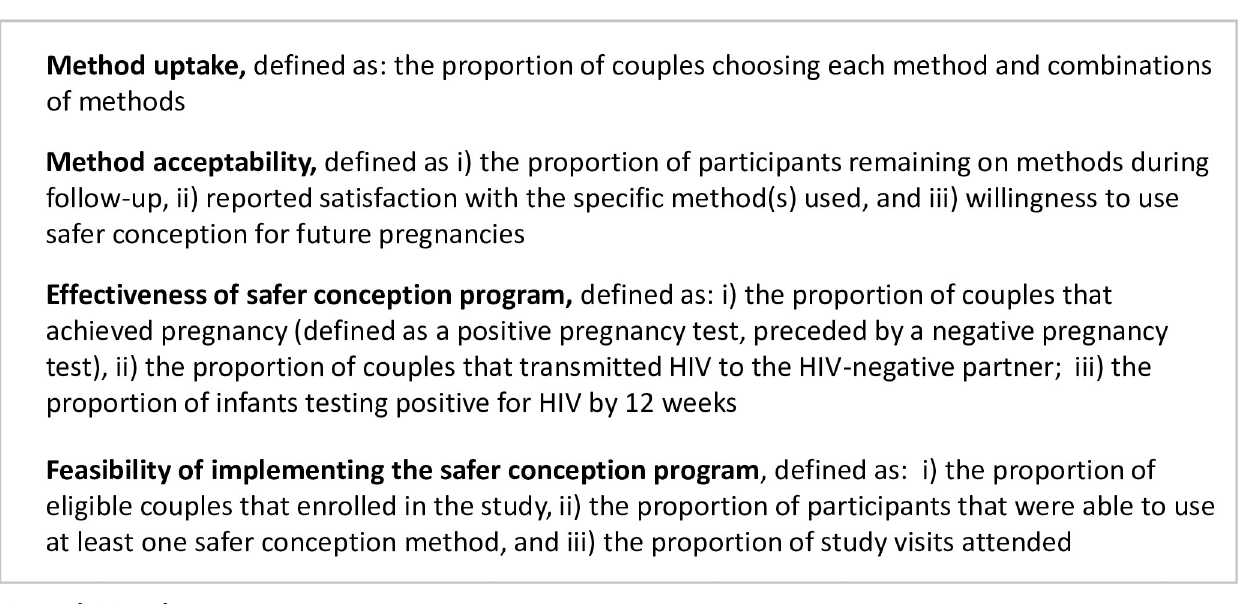
Fig 4. Definitions of outcome measures.